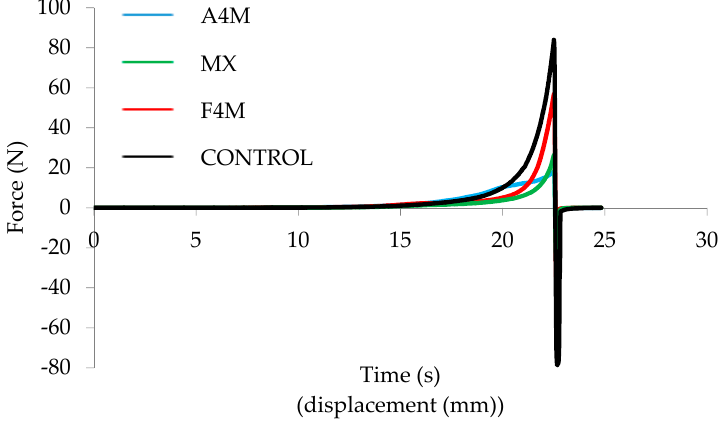
ff erent studied Figure 2. Spreadability curves of the different studied spreads. Figure 2. Spreadability curves of the di Figure 2. Spreadability curves of the different studied spreads.